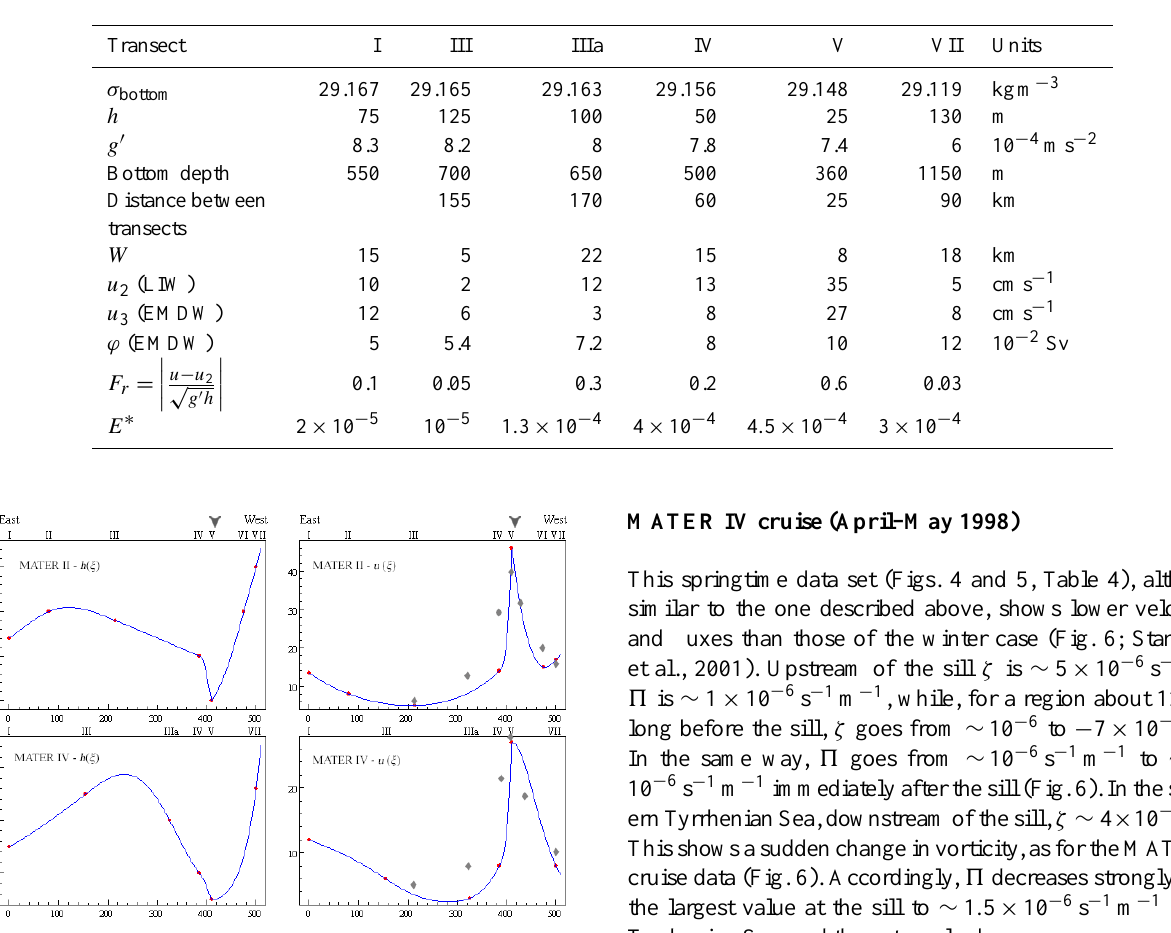
Table 2. As Table 1, but for the MATER IV cruise (Figs. 1 and 4).